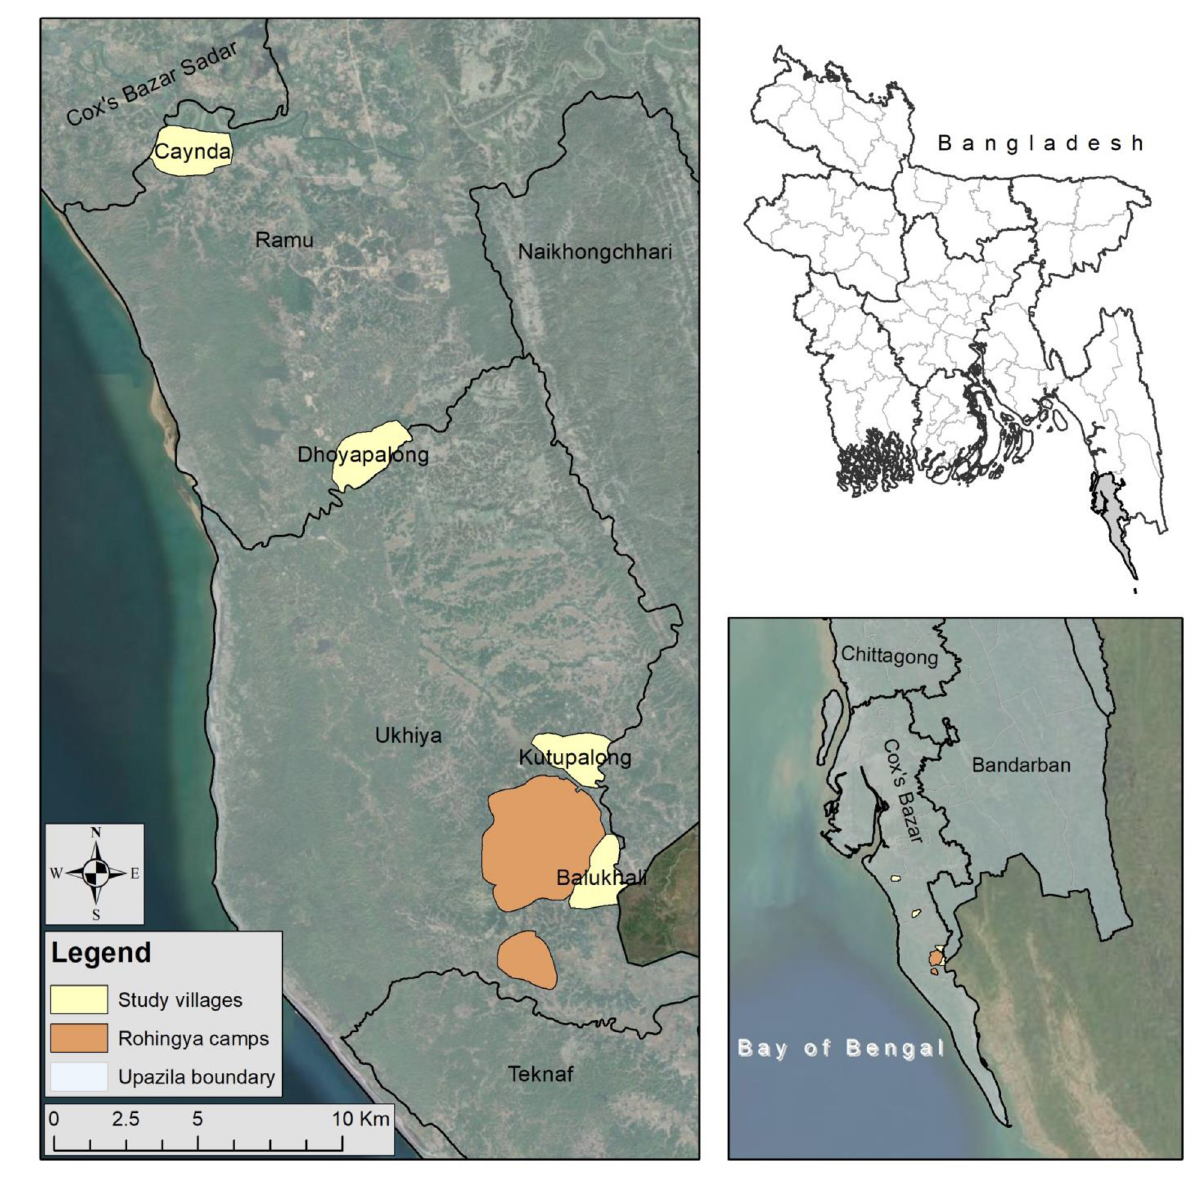
Fig 1. Study area location. Source: Authors’ compilation,